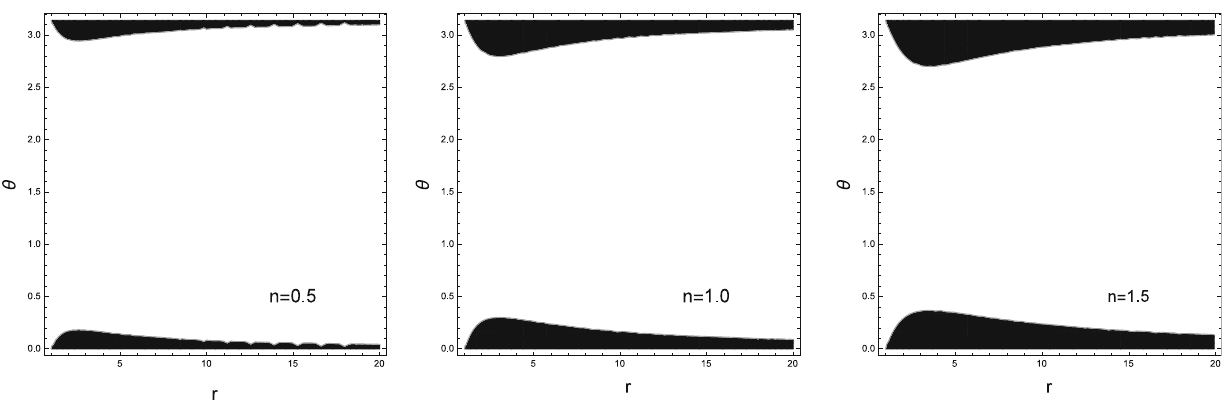
Fig. 1 The contour curves g φφ = 0 for the extremal KTN black hole with different n . In the black region, the function g φφ < 0 and then the closed timelike curves exist. In the white region, there is no closed timelike curves since g φφ > 0. Here, we set M =